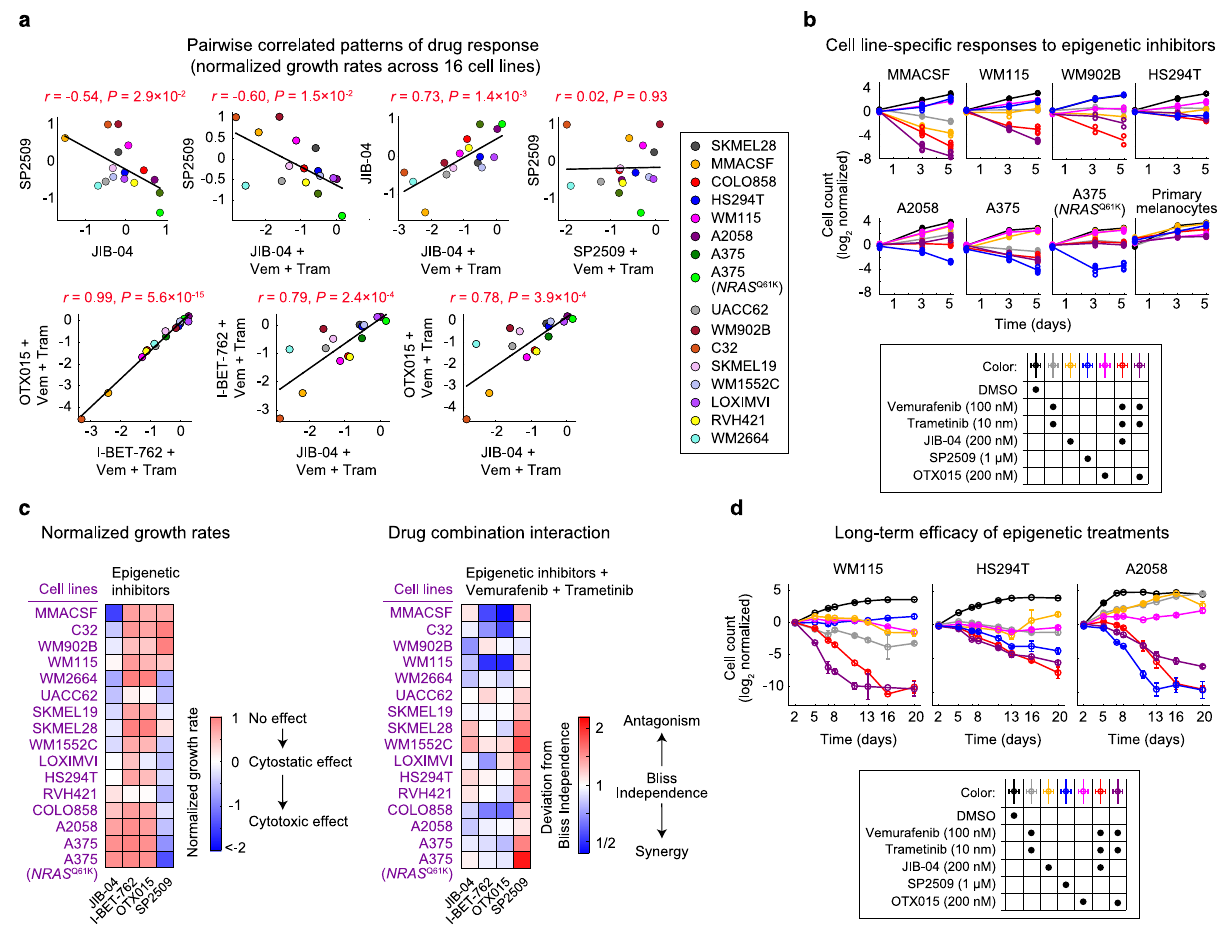
Fig. 4 Correlated patterns of sensitivity to pharmacological inhibition of Kdm1a, Jmj-KDMs, and BET proteins across 16 BRAF -mutant melanoma cell lines. a Two-sided Pearson ’ s correlation between the effects (i.e., normalized growth rates) of Kdm1a inhibitor SP2509 (at 1 μ M), Jmj-KDM inhibitor JIB-04 (at 200 nM), BET inhibitors OTX015 (at 200 nM), and I-BET762 (at 1 μ M), used individually or in combination with vemurafenib (at 100 nM) plus trametinib (at 10 nM) and evaluated across 16 BRAF -mutant melanoma cell lines. b Log 2 -normalized changes in live cell count following exposure of seven selected melanoma cell lines and non-transformed primary melanocytes to different drugs at indicated doses for a period of 5 days. MMACSF, WM115, and WM902B cell lines represent cell lines that exhibit high sensitivity to the combination of JIB-04 or BET inhibitors with Braf/Mek inhibitors, while being resistant to SP2509. A2058, A375, and A375( NRAS Q61K ) represent cell lines that are highly sensitive to SP2509. HS294T cells show partial sensitivity to either of the compounds. Data are presented as the average of n = 6 biologically independent samples (in case of MMACSF, WM115, HS294T, A2058, A375, A375( NRAS Q61K ) and primary melanocytes), or the average of n = 2 biologically independent samples (in case of WM902B). c Measurements of normalized growth rate (left) and deviation from Bliss independence (DBI) values computed across diverse epigenetic inhibitor treatments in combination with vemurafenib plus trametinib. Experimental conditions and the analysis approach are the same as in Fig. 3. d Log 2 -normalized changes in live cell count following exposure of three selected melanoma cell lines to different drugs at indicated doses for a period of 20 days. Data are presented as mean values ± s.d. across n = 4 biologically independent samples. Source data are provided as a Source data fi